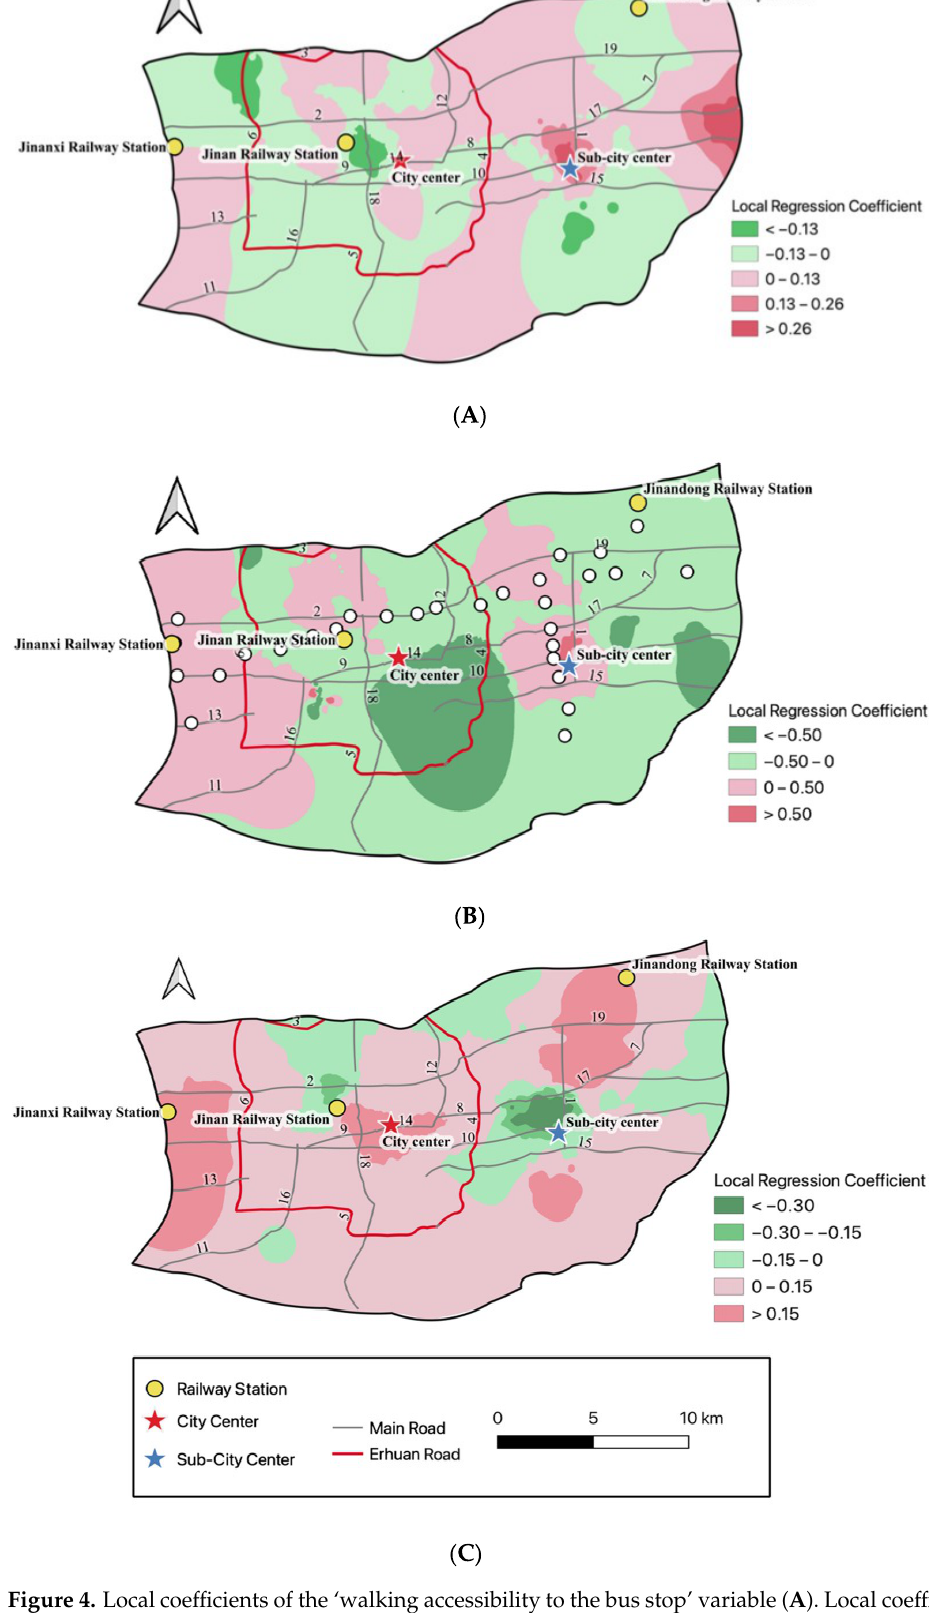
Figure 4. Local coefficients of the ‘walking accessibility to the bus stop’ variable ( A ). Local coefficients of the ‘proximity to a subway station’ variable ( B ). Local coefficients of the ‘proximity to bus lines’ variable ( C